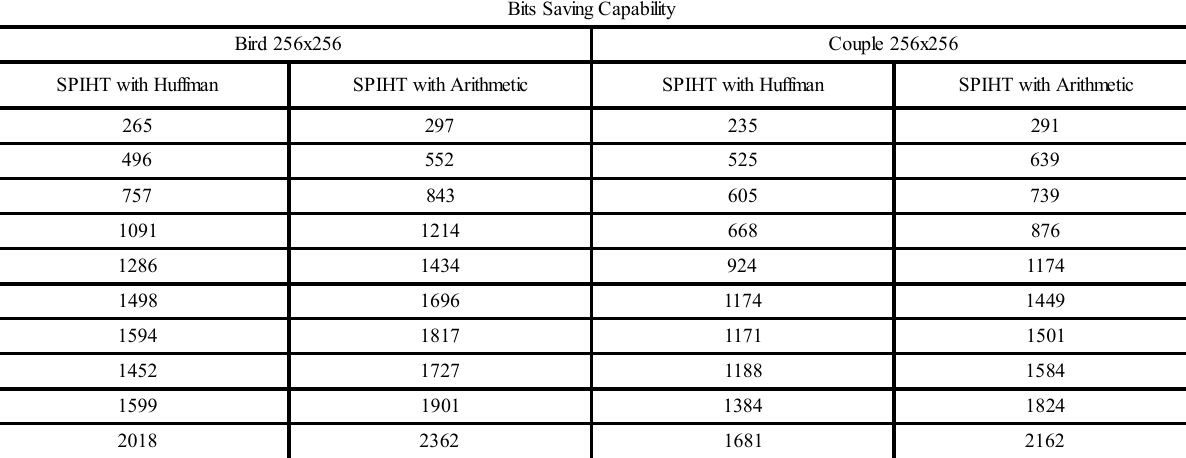
TABLE 13. ELAPSED TIME FOR BOTH ALGORITHMS FOR OTHER